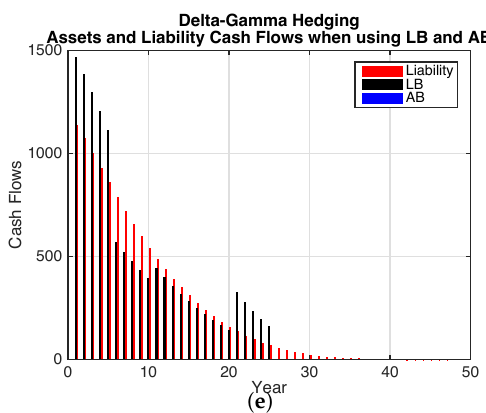
Figure 4. Asset and Liability Cash Flows—Hedging. ( a ) Only Coupon Bonds; ( b ) Only Annuity Bonds; ( c ) Only Longevity Bonds; ( d ) Coupon Bonds and Longevity Bonds; ( e ) Coupon Bonds and Longevity